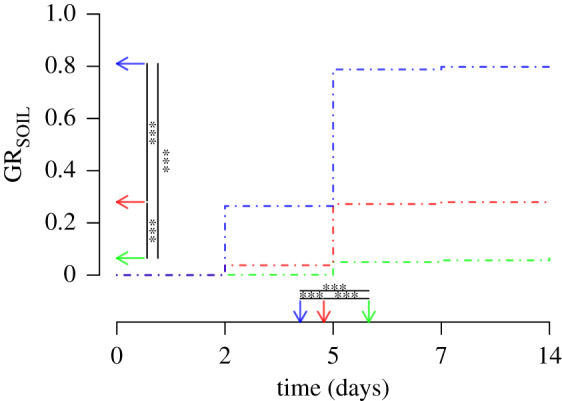
Germination rate of the progeny (GRSOIL) in soil at different time points (days) according to geographical origin. The dot-dashed lines indicate the dynamic of the germination for the three geographical areas: Asia (green, GR = 0.07), Europe (red, GR = 0.28), Middle East (blue, GR = 0.81). The vertical arrows indicate the mean germination time, and the horizontal arrows the proportion of germination for each geographical area. The asterisks indicate significant differences between the three regions (*p < 0.05; **p < 0.01; ***p < 0.001). (Online version in colour.)